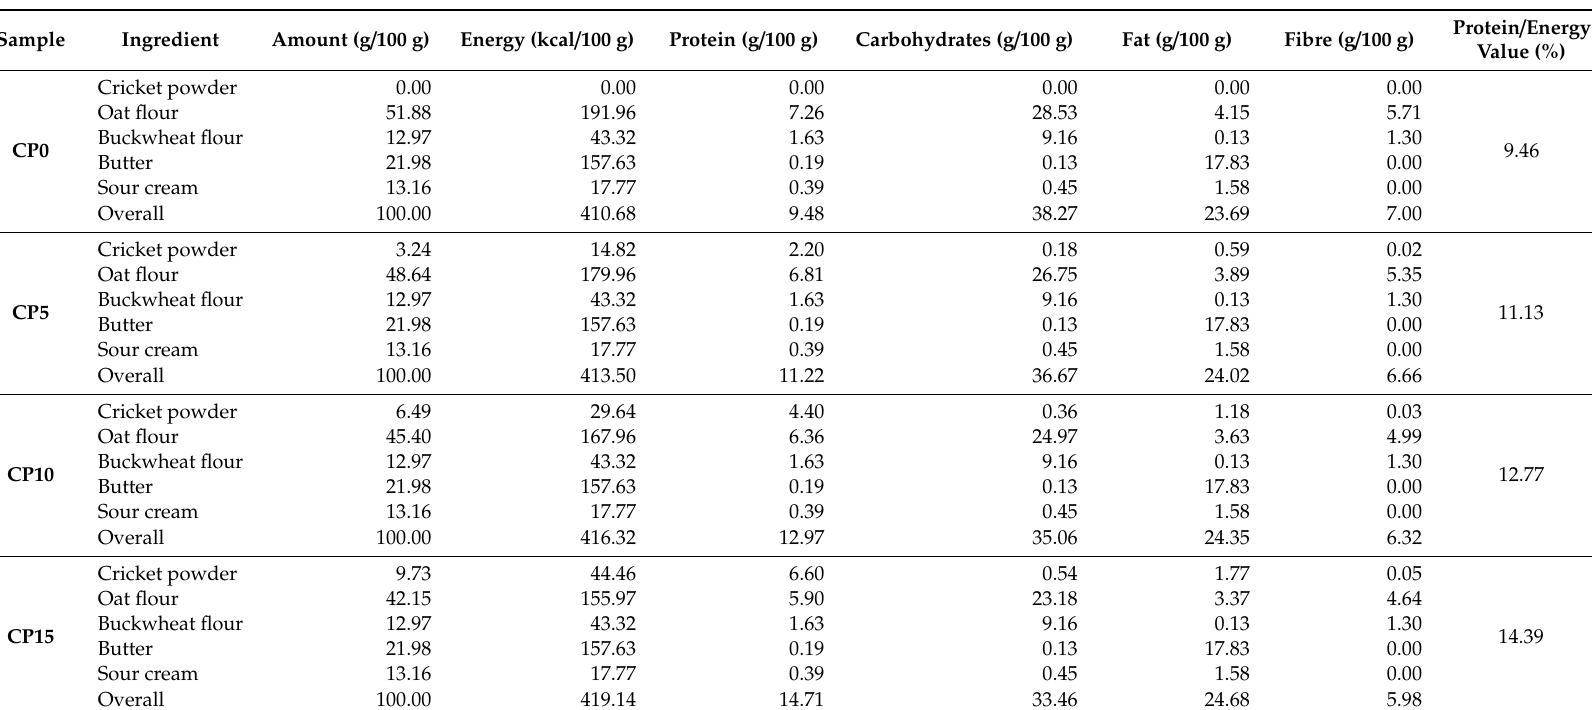
Table 4. Biscuit compositions and calculated nutritional values. Amounts of each material are presented next to the name of the material. Nutritional values correspond to the quantity each sample contains. The table only lists the ingredients which contain energy-providing